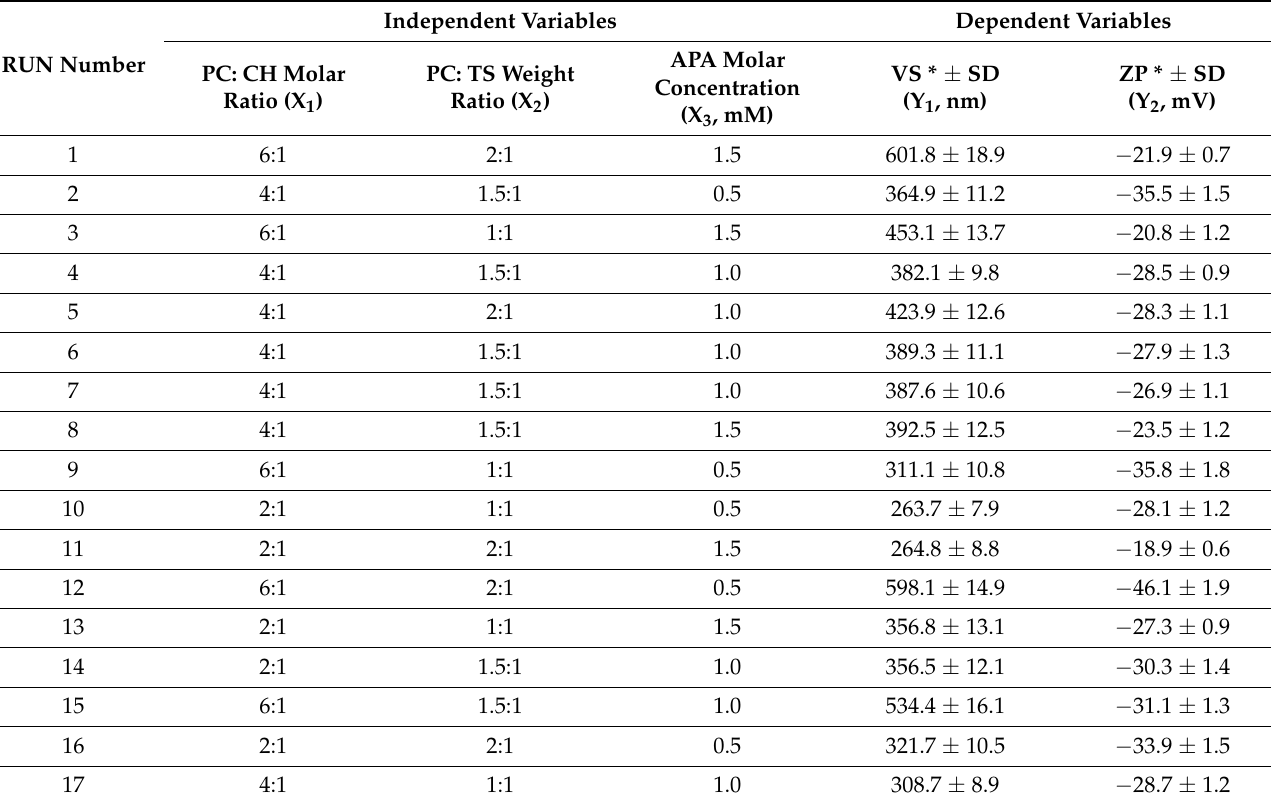
Table 2. Independent variables’ levels in EGA-EML-APA experimental runs and their measured